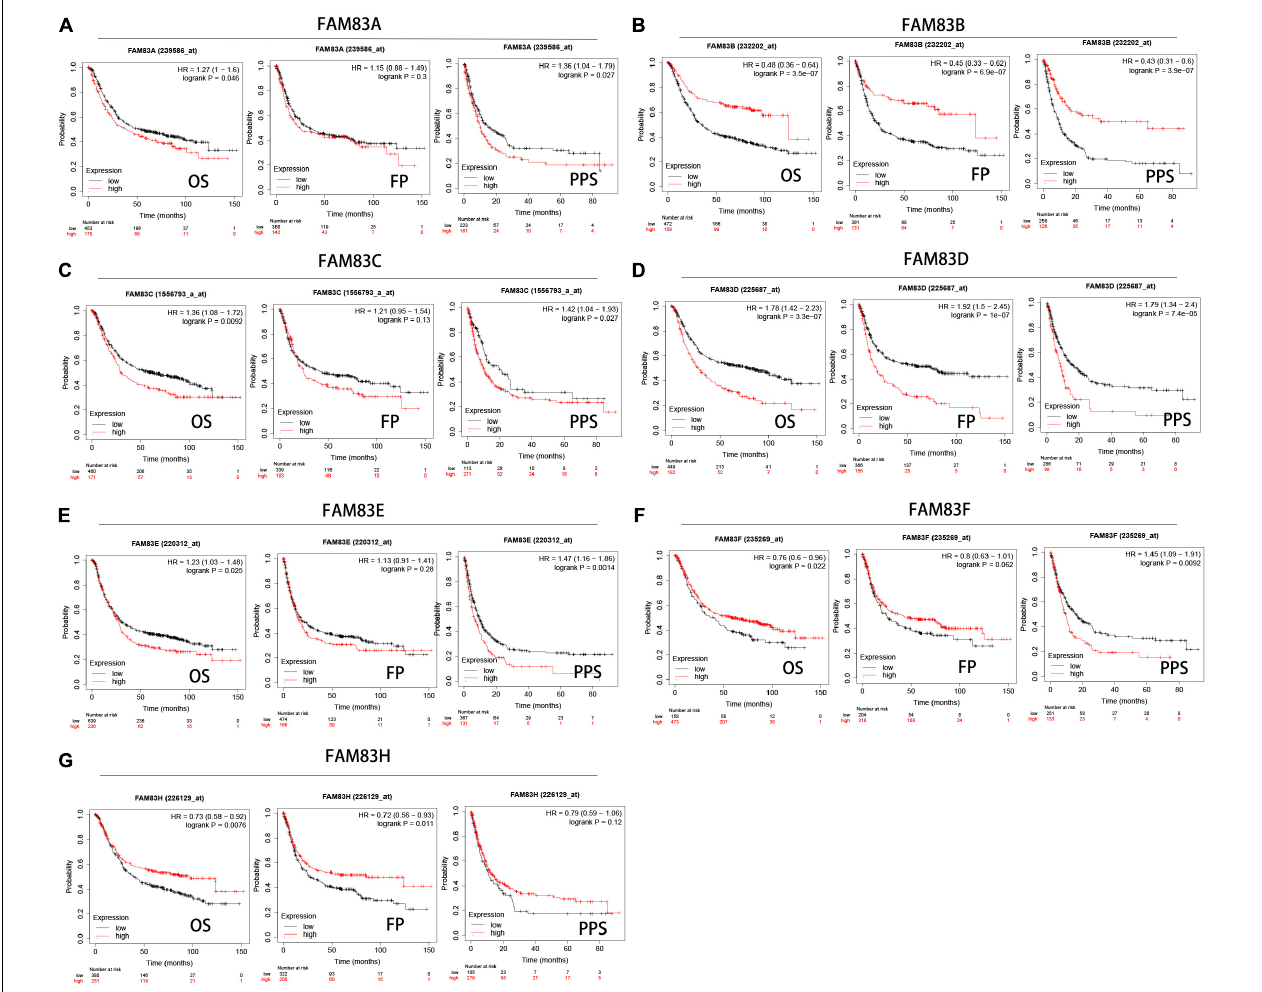
FIGURE 7 | (A–G) Prognostic analysis of FAM83 family members in gastric cancer patients (Kaplan–Meier plotter). The Kaplan-Meier plotter database was used to plot OS, FP, and PPS survival curves at the threshold of p -value < 0.05 to compare patients with high (red) and low (black) expression of FAM83 family members in gastric